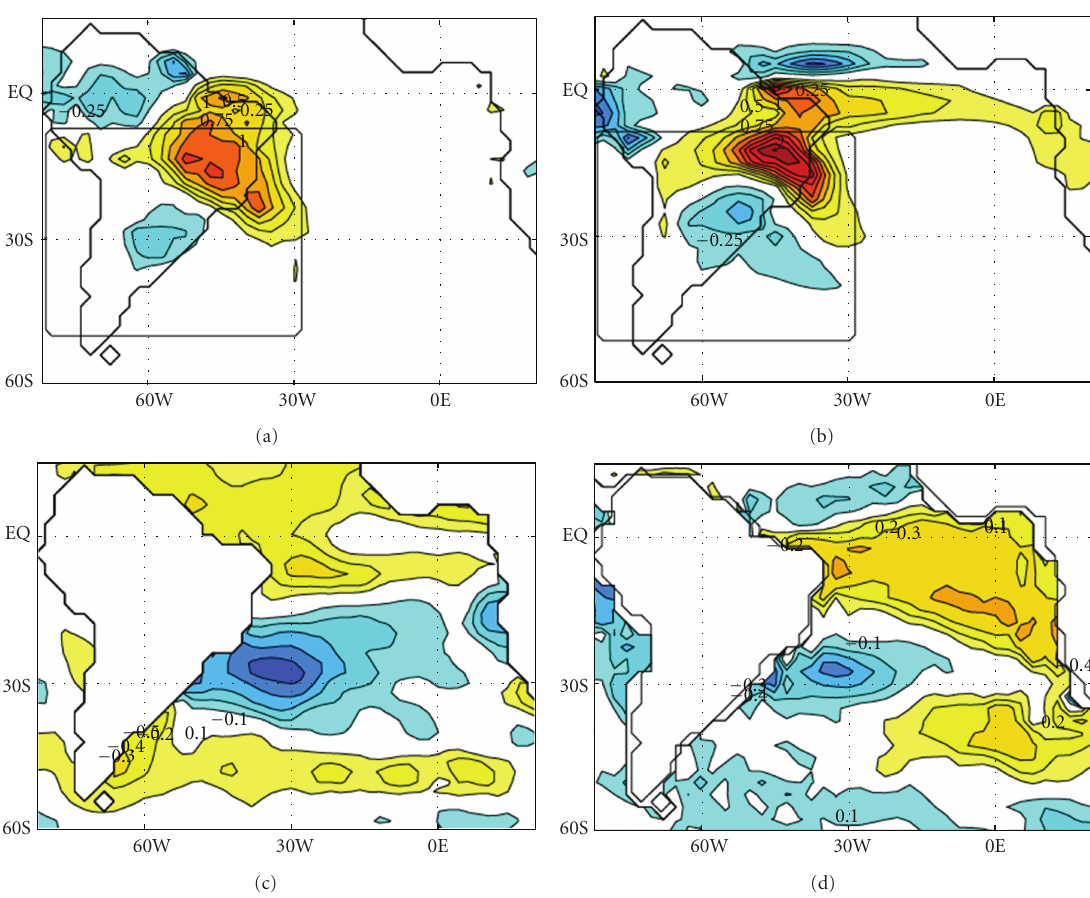
Figure 1: (a) First EOF of interannual DJF rainfall variability calculated over the region (50 ◦ S–10 ◦ S; 280 ◦ E–330 ◦ E) (dashed box) for observations. Contour interval: 0.25 mm/day. The map is constructed by linear regression of the precipitation field onto the time series associated with the EOF. (b) Idem (a) for the HadCM3 20th-century run. (c) Correlation between time series associated with the EOF shown in (a) and SST anomalies for observations. Contour interval: 0.1. Correlation values higher (lower) than 0.35 ( − 0.35) are significant at a 5% level according to a two-tailed Student t -test. (d) Correlation between time series associated with the EOF shown in (b) and SST anomalies for the HadCM3 20th-century run. Contour interval: 0.1. Correlation values higher (lower) than 0.2 ( − 0.2) are significant at a 5% level according to a two-tailed Student t